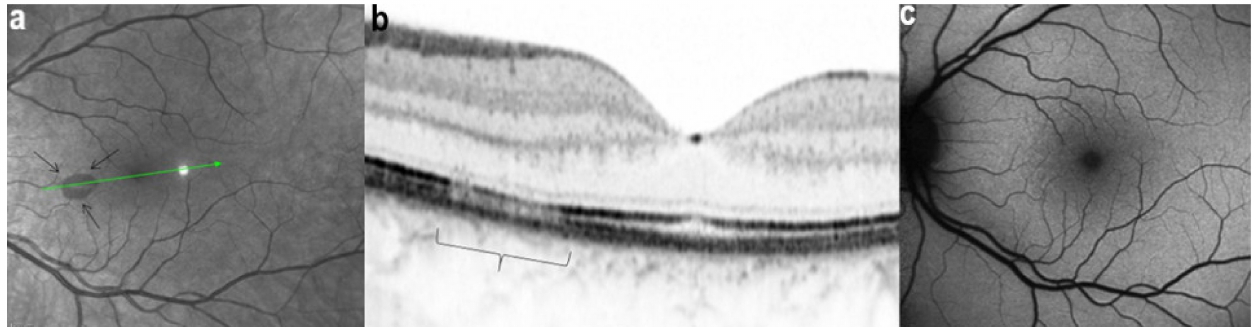
Figure 31. AMN. NIR-R, SD-OCT and FAF images at eight days after the onset of symptoms. ( a ): NIR-R imaging shows a sharply oval hyporeflective area (arrows) corresponding, on SD-OCT ( b ), to an attenuation of the EZ whereas the IZ is not seen (b, bracket). ( c ): BAF signal is